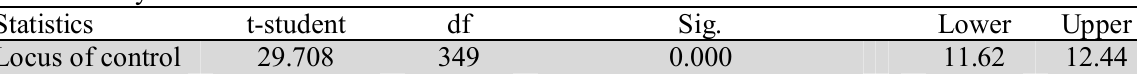
The summary of t-student test